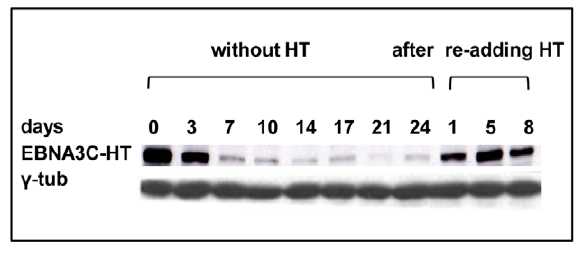
Figure 1. EBNA3C inactivation and reactivation in LCL 3CHT. Cells that had been grown in culture medium containing HT were washed and re-suspended in medium with HT omitted. After culturing for the number of days indicated, protein extracts were western blotted and probed with an anti-EBNA3C MAb to reveal EBNA3C-HT. After 17 days some cells were transferred to medium containing HT and after 1, 5 or 8 days samples were again taken for western blotting. The western blot was re-probed with anti- c -tubulin to ensure equal loading of